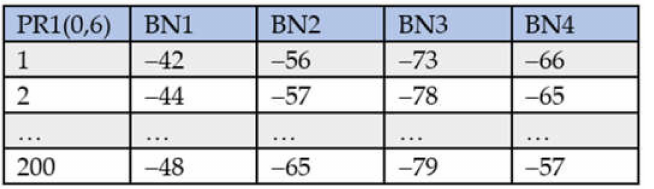
Figure 2. BLE RSSI fingerprint data for a reference point. Adapted from ref. [39]. © IEEE